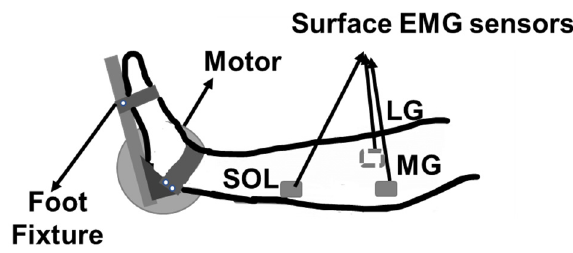
Figure 1. Schematic diagram of experimental setup.